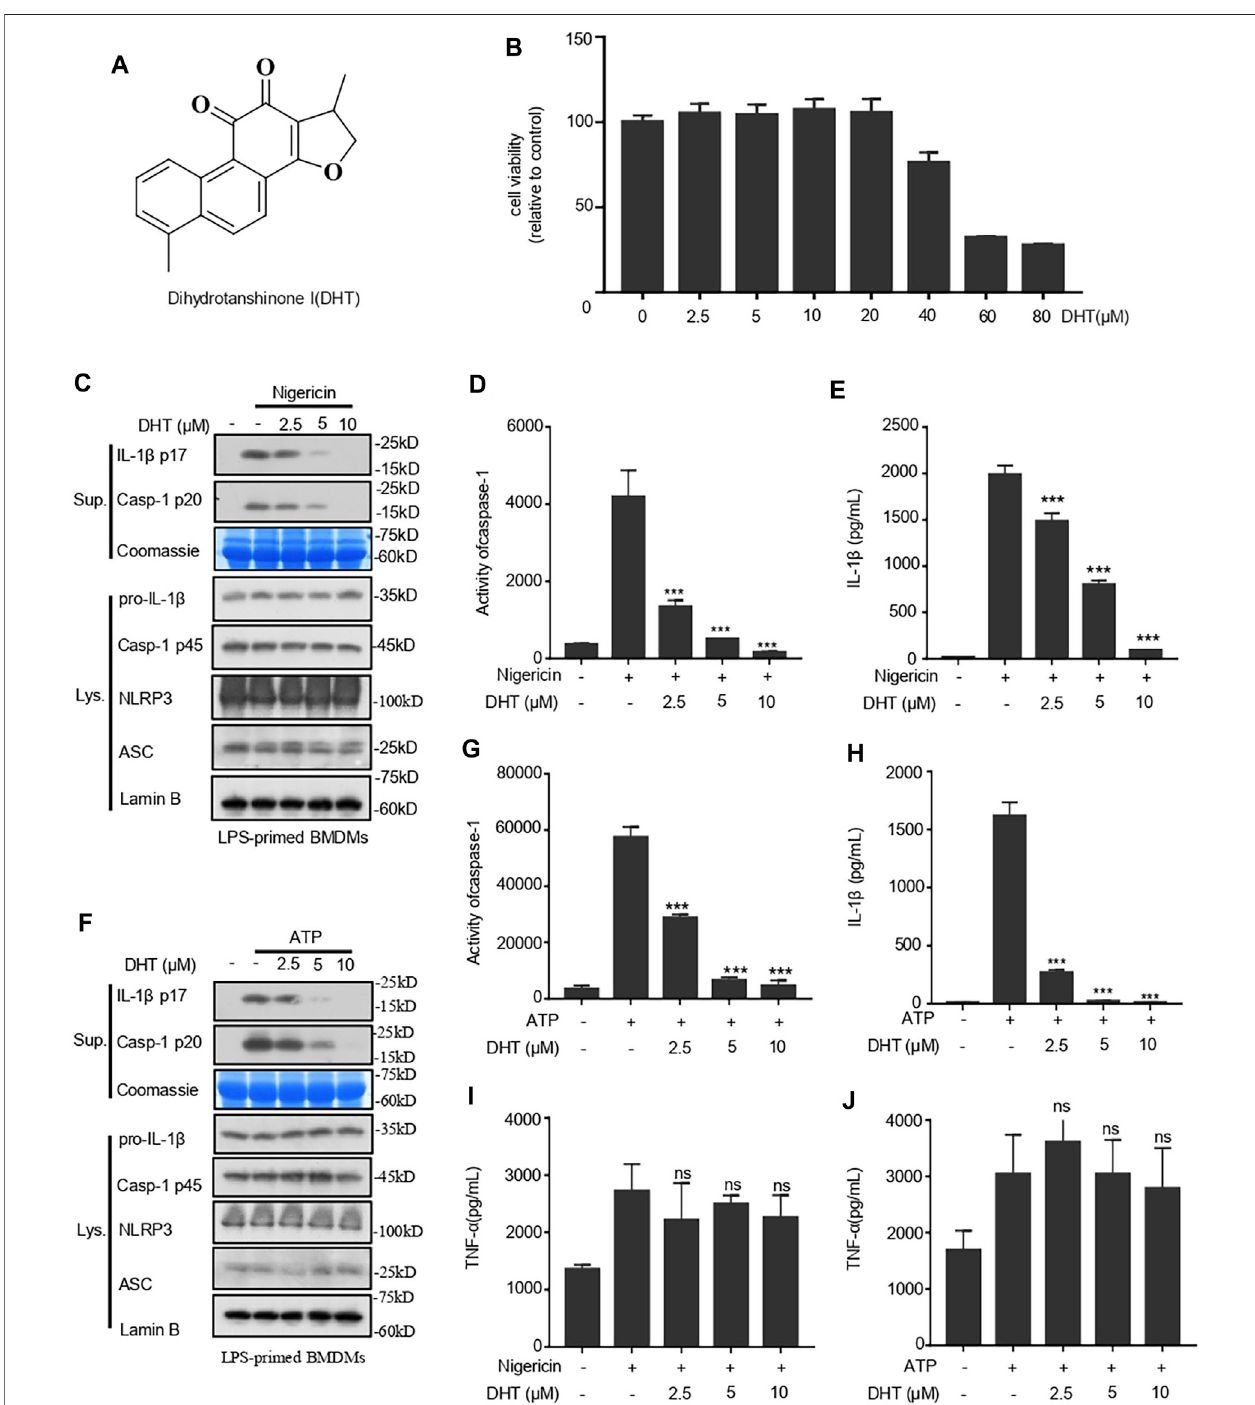
FIGURE 1 | Dihydrotanshinone I (DHT) blocks NLRP3 in fl ammasome activation induced by nigericin and ATP in BMDMs. (A) Dihydrotanshinone I structure. (B) BMDMs were exposed to DHT (2.5 – 80 μ M) for 24 h. (C – E) BMDMs were primed with LPS and then exposed to different concentrations (2.5, 5, or 10 μ M) of dihydrotanshinoneI,followedbythestimulationofnigericinfor0.5 h.ImmunoblottinganalysisofIL-1 β (P17)andactivatedcaspase-1(P20)incellsupernatants(Sup.)are shown (C) .Caspase-1activity (D) andIL-1 β (E) secretionweremeasured. (F – H) BMDMswereprimedwithLPSandthentreatedwithdifferentconcentrations(2.5, 5, or 10 μ M) of dihydrotanshinone I, followed by the stimulation of ATP for 1 h. Western blot analysis of matured IL-1 β (P17) and activated caspase-1 (P20) in culture supernatants (Sup.) are shown (F) . Caspase-1 activity (G) and IL-1 β (H) secretion are measured. (I and J) The secretion of TNF-a in the supernatant of cells treated as described in C (I) and F (J) were determined by ELISA. Coomassie blue staining was used as the loading control of the supernatant (C, F) and Lamin B was used as the lysate loading control (C, F) . Results are represented as mean ± SEM from three biological replicates. One-way ANOVA was used to analyze the data. * p < 0.05, ** p < 0.01, *** p < 0.001, NS: not signi fi cant.